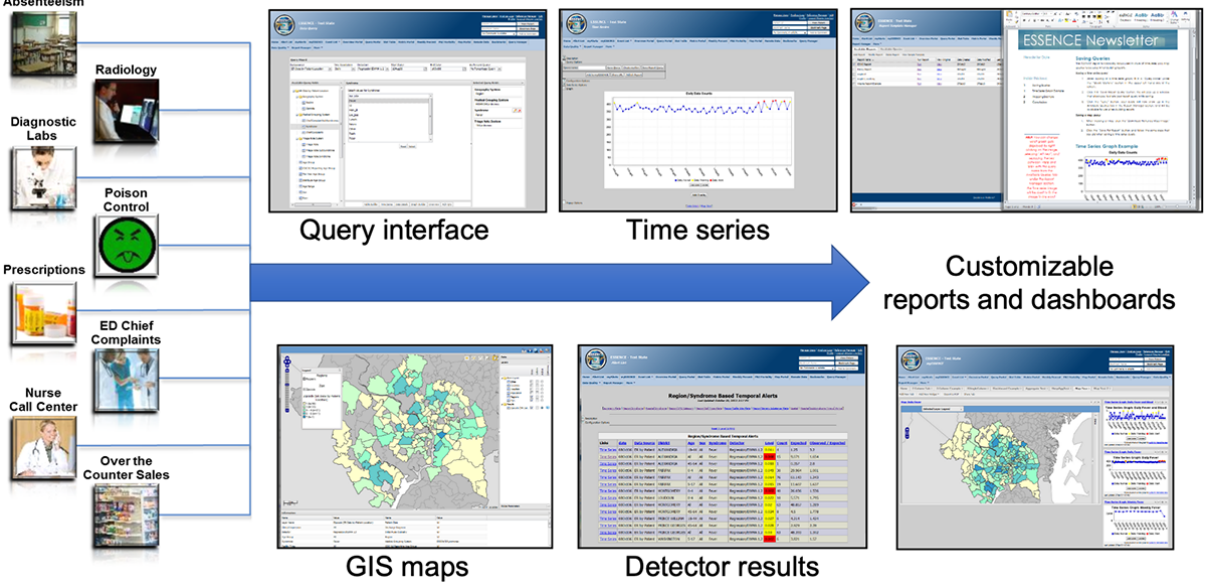
Figure 1. Schematic overview of Electronic Surveillance System for the Early Notification of Community-Based Epidemics (ESSENCE) features showing a sampling of users’data types, analysis modes, and screen interfaces. ED: emergency department; GIS: geographic information